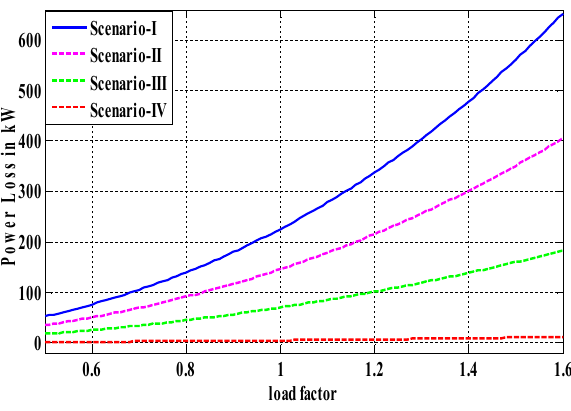
Figure 11. Comparison of active power loss for various scenarios (IEEE 69-Bus).